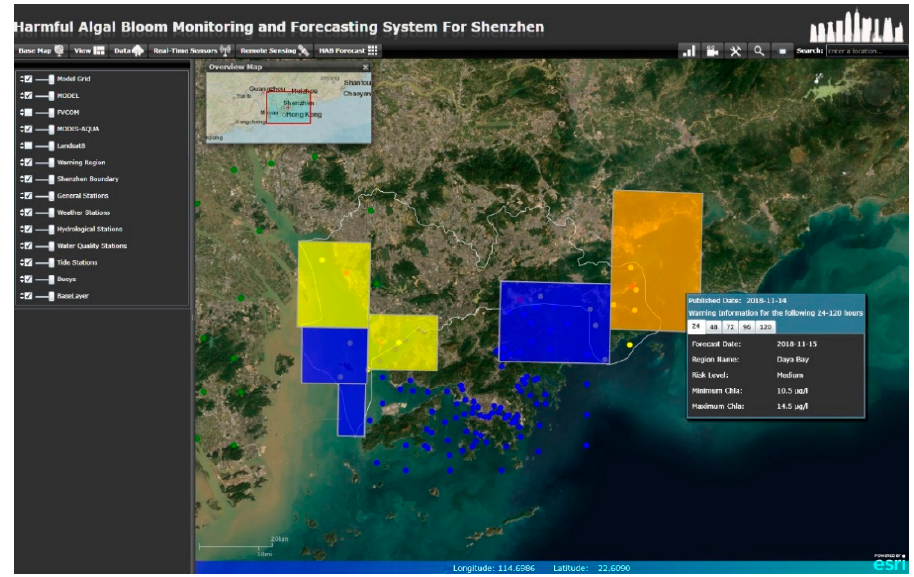
Figure 12. Early warning information of potential HAB, even in the Shenzhen coastal areas.